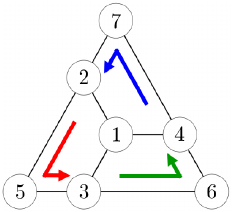
FIG. 4. An example of the orderings of CNOT gates for the 3D color code of distance 3 in H form which give a distinguishable fault set F 1 . For each f generator, the qubits on which data CNOT gates act start from the tail of each arrow, then proceed counter- clockwise. The ordering of CNOT gates for the cap generator is determined by the qubit numbering.